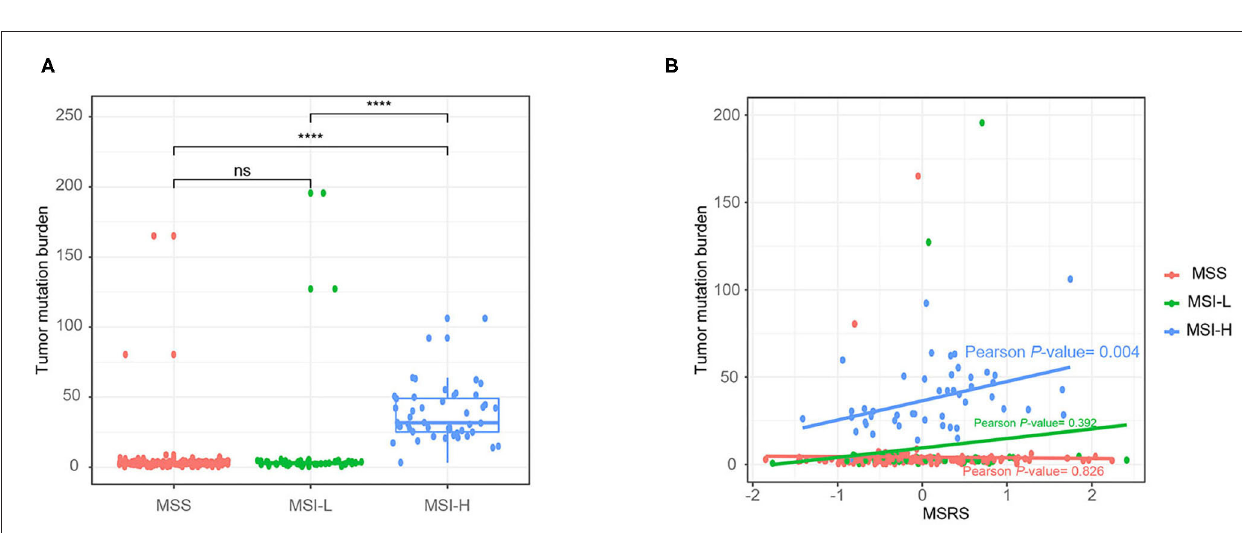
FIGURE 7 | Boxplot showing number of gene mutations against microsatellite status (A) and the association between number of gene mutations and the MSRS Mann–Whitney U- test (B) ; ns: p > 0.05; * P < 0.05; ** P < 0.01; *** P < 0.001; **** P <